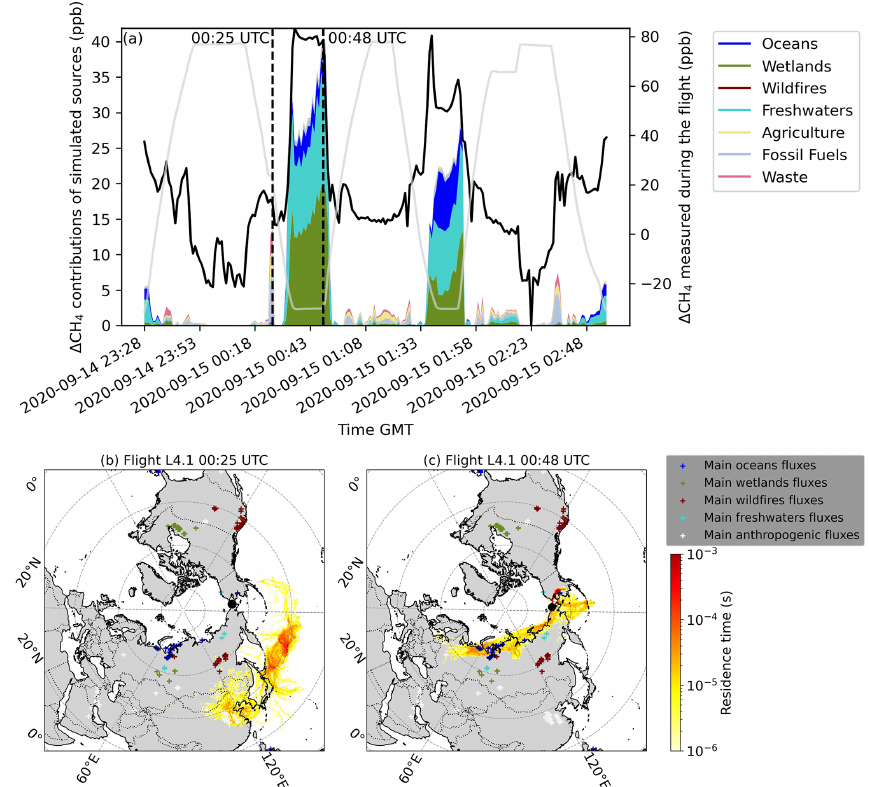
Figure 11. (a) Simulated CH 4 enhancement (colored stacked plot) and measured CH 4 (black line) for flight L4.2. Note the different y axes. Altitude is shown in gray (bottom at 38 and top at 8707m). The two vertical dotted lines indicate the measurements represented in the following footprints. (b) The 10d potential emission sensitivity (PES) for particles released at 00:25UTC. (c) Same as (b) at 00:48UTC. The colored “ + ” symbols represent the fluxes with the biggest intensities derived from each inventory. The black dot represents the receptor